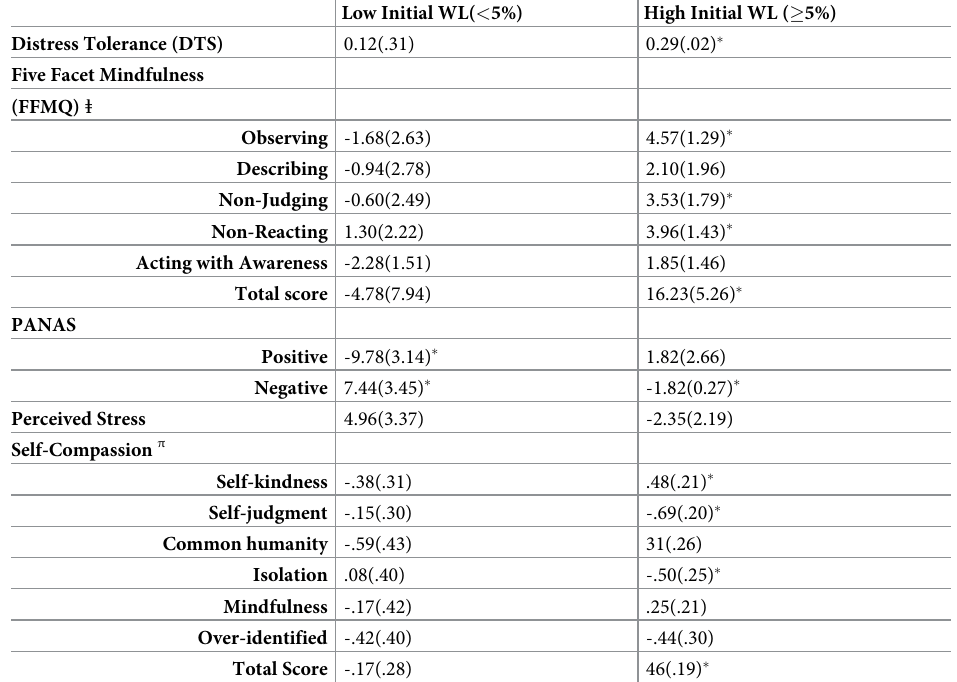
Table 4. Between-group differences in psychological constructs at 6 months stratified by initial weight